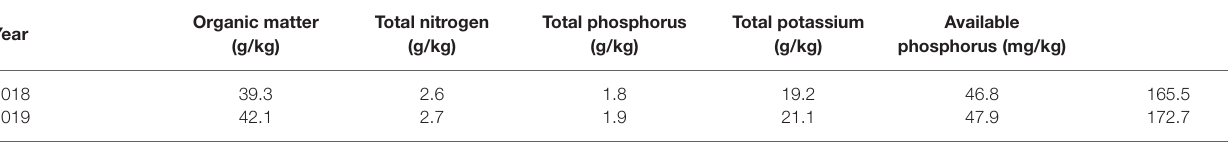
TABLE 1 | Physicochemical property of soils used for the tests in 2018 and